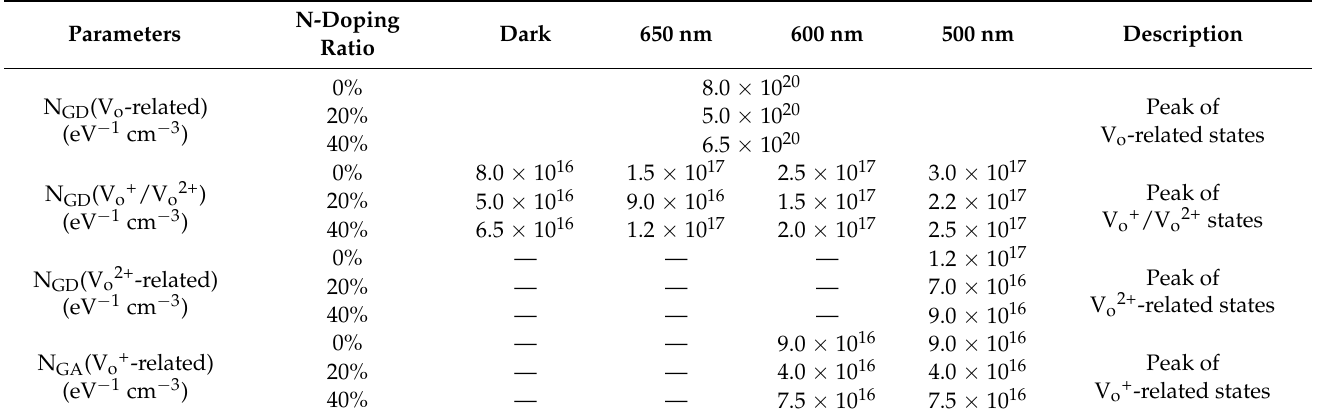
Figure 7. Simulated transfer characteristics against various monochromatic light illumination for the a-IGZO TFTs fabricated with different N-doping ratios: ( a ) undoping, ( b ) 20% N-doping ratio, and ( c ) 40% N-doping ratio. Table 3. Densities of key defect model parameters for a-IGZO TFT fitted with different N-doping ratios after monochromatic light illumination.